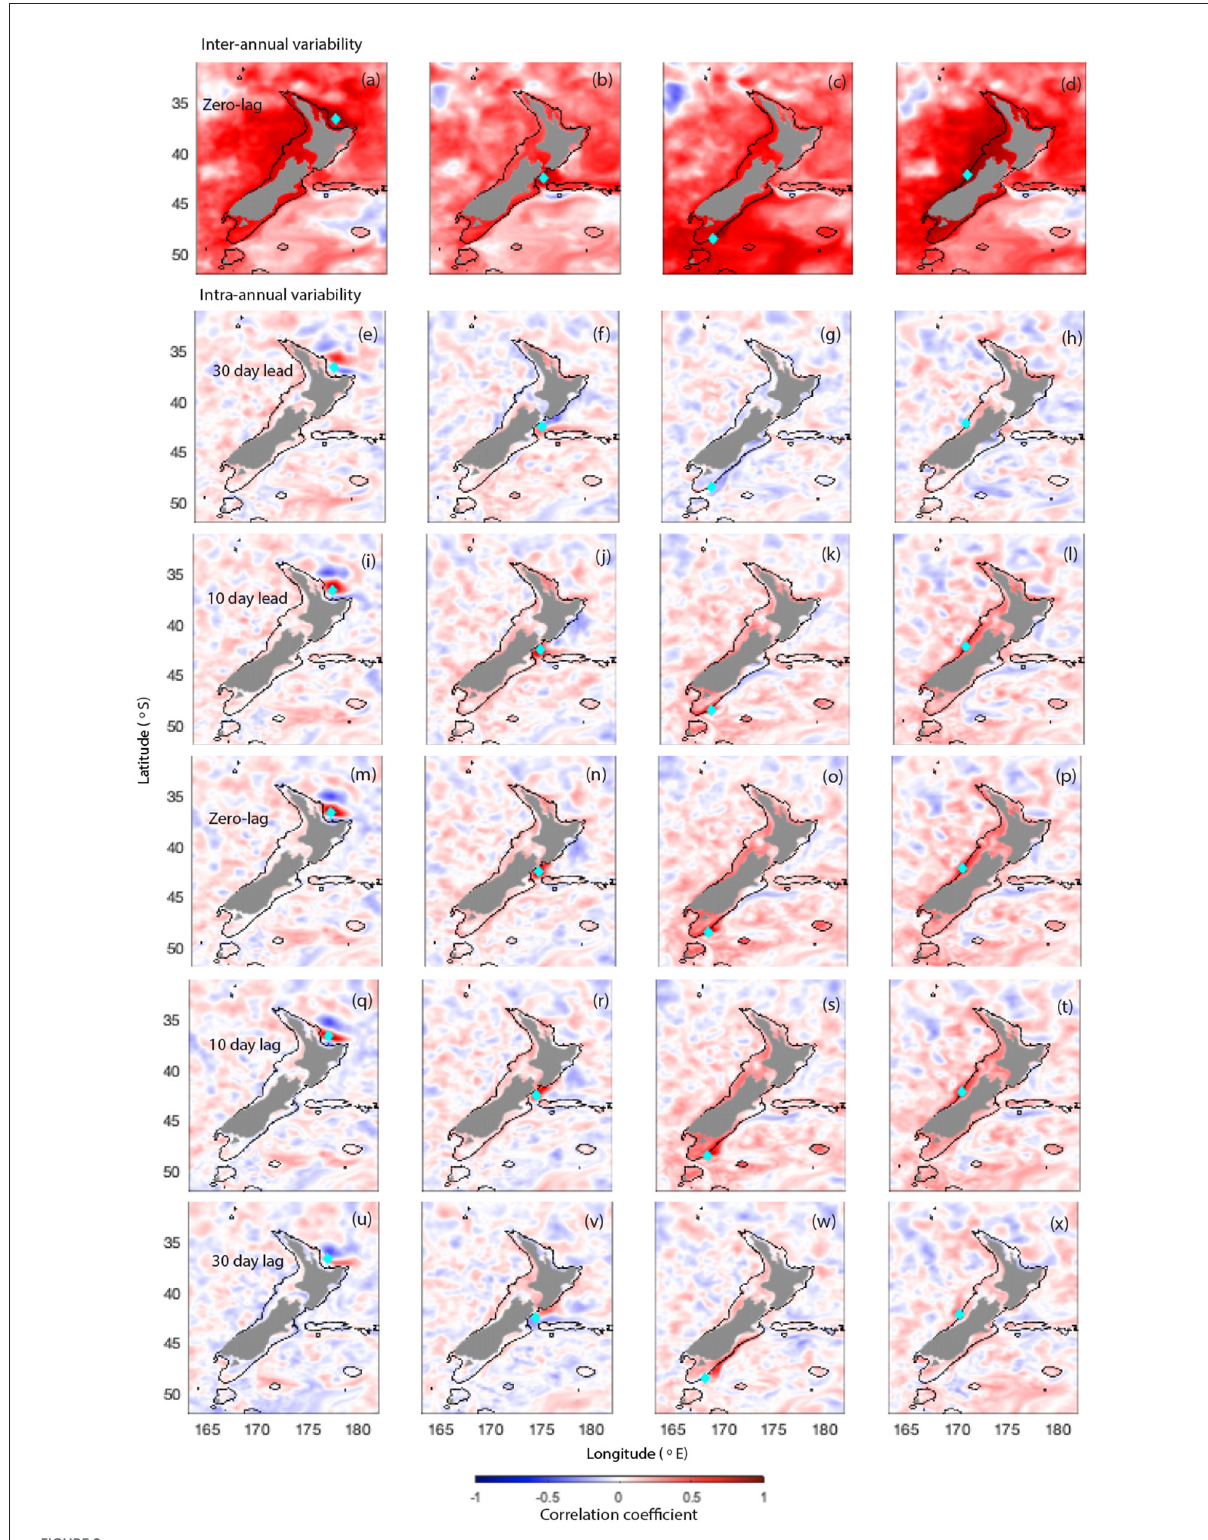
FIGURE2 Correlation of UOHC at a given point (shown by turquoise diamond) to UOHC across domain for inter-annual periods at zero-lag (a–d) and intra-annual periods at 30 day lead (e–h) , 10 day lead (i–l) , zero-lag (m–p) , 10 day lag (q–t) , and 30 day lag (u–x) . The points are in regions (from left to right) 1. Bay of Plenty, 2. Kaikoura, 3. Stewart Plateau and Snares Shelf 4. Hokitika. The 400 m bathymetry contour is